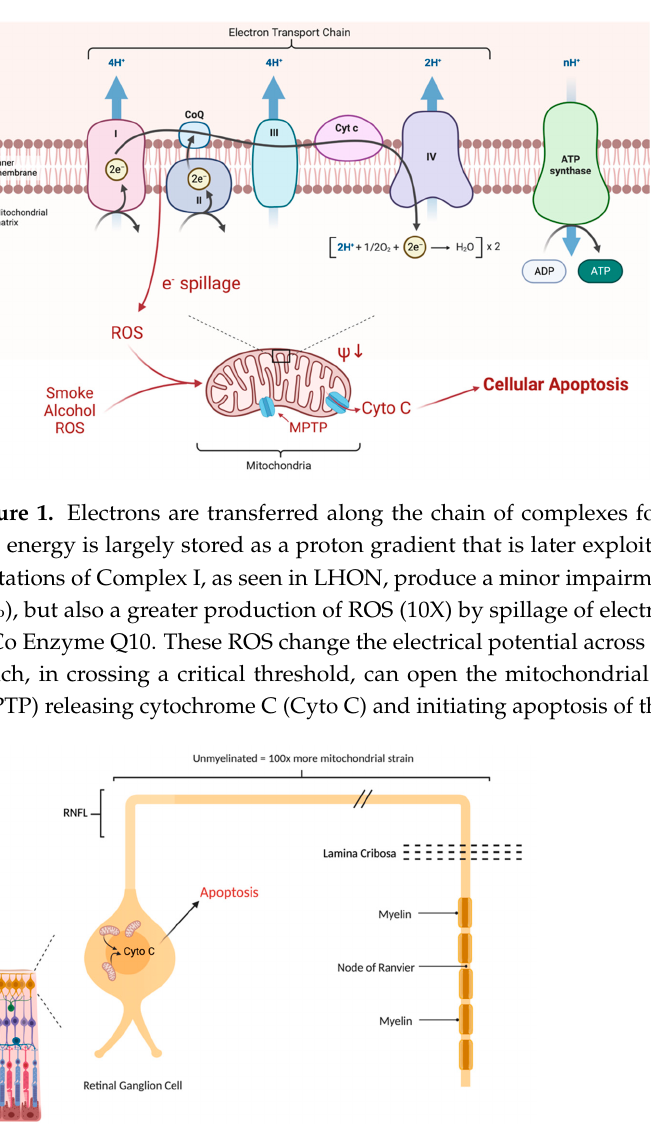
Figure 3. Comparison of the metabolic strain in smaller axons that are concentrated in the papillo- macular bundle (PMB). The smaller fiber ( A ) typically has a diameter of only 0.4 microns. Compared to the larger fibers of the nasal retina ( B ), the PMB fiber has a much-reduced volume and hence fewer mitochondria. Although its surface area is a little less as well, the area/volume ratios are six times worse in the smaller fibers, explaining why they are the first to die in LHON. Figures created with biorender.com. 4. Unaffected Carriers and Pre-Symptomatic/Pre-Clinical Currently, there is no recommended treatment for those individuals who are known carriers of the LHON mutation [2]. That being said, there are important factors to consider in these individuals based on the newest insights we have available regarding LHON.